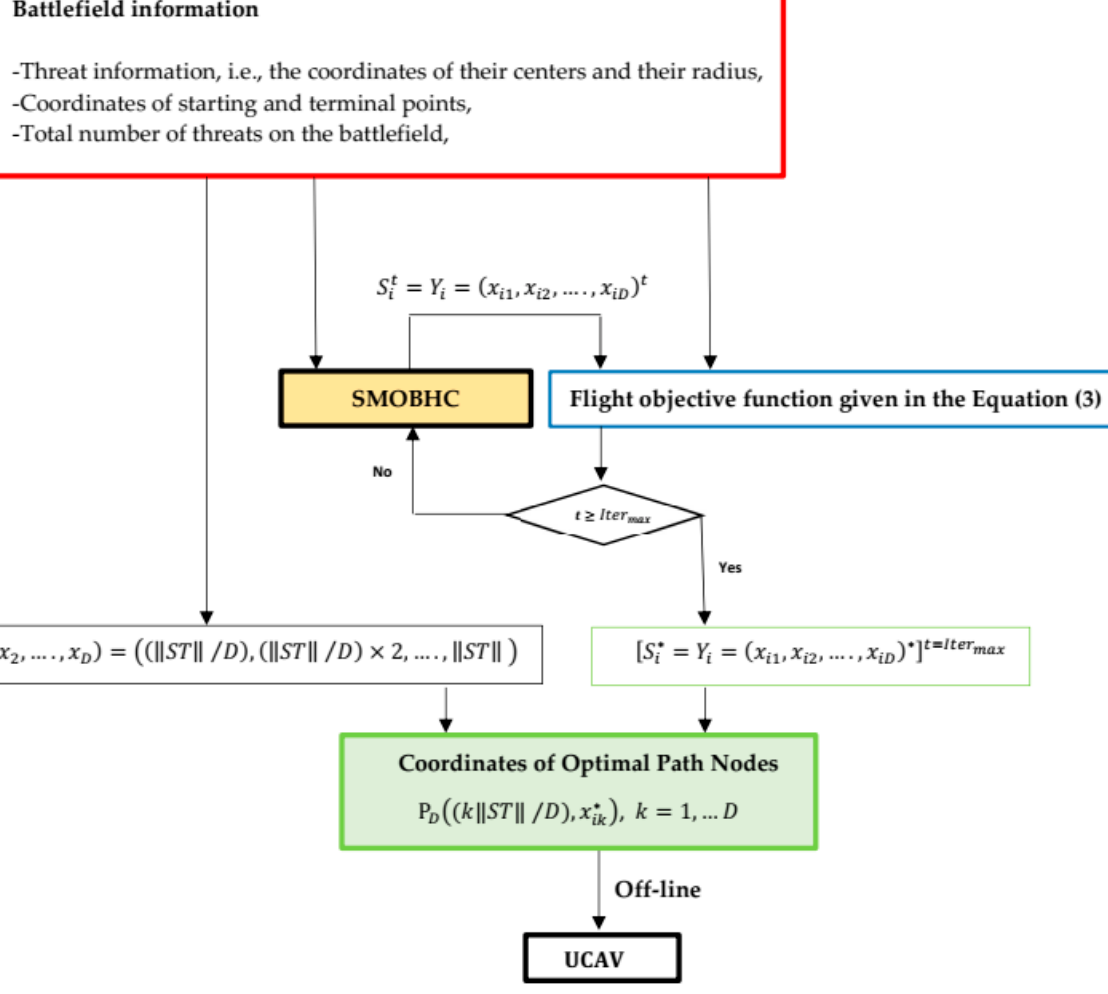
Figure 7. Graphical representation of UCAV Path planning based on SMOBHC.